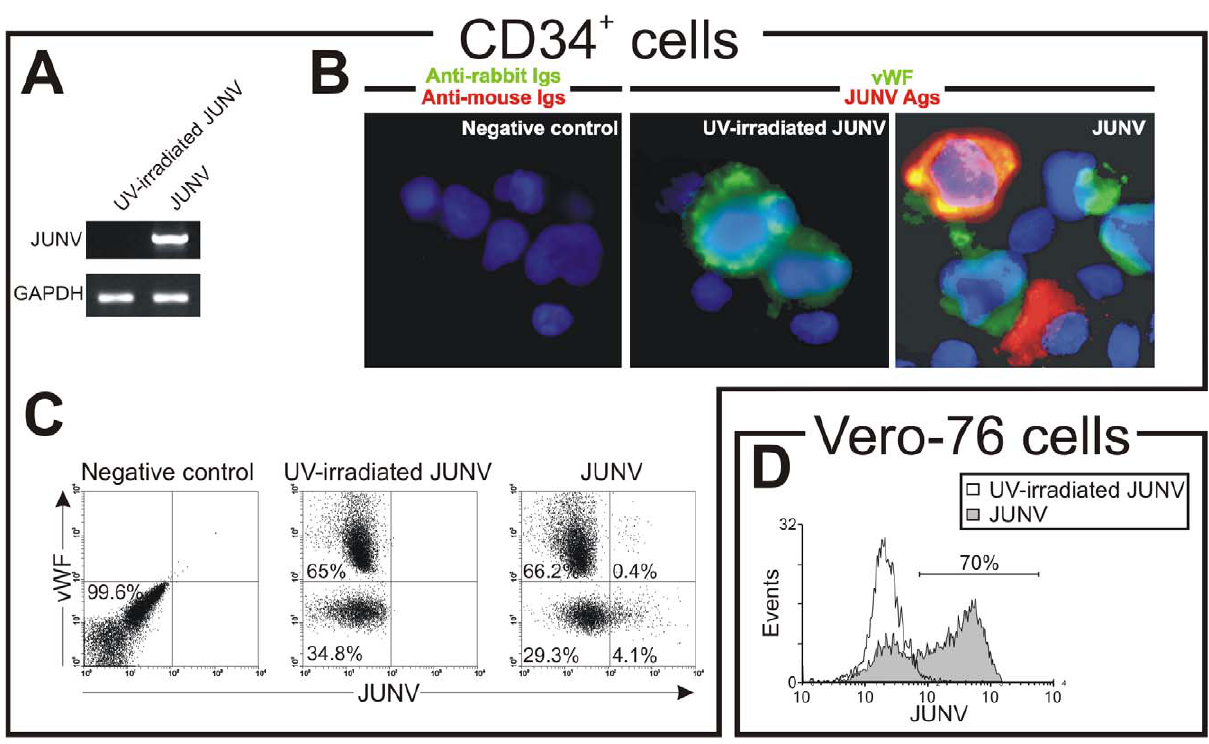
Figure 4. JUNV replication in CD34 + cells. CD34 + cells were inoculated with UV-irradiated JUNV or JUNV and stimulated with TPO for ten days. Viral replication was assayed by RT-PCR, immunofluorescence and flow cytometry. (A) RT-PCR studies. (B) To detect JUNV antigens by immunofluorescence cells were washed, cytocentrifuged on silanized glasses, fixed, permeabilized and incubated first with a pool of specific mAbs against JUNV and a rabbit-anti-human vWF polyclonal Ab to identify megakaryocytes, and then with FITC-conjugated anti-rabbit (green) and Cy3- conjugated anti-mouse Igs (red). The slides were counterstained with DAPI and photographed at 1000 6 magnification. (C) Cells were stained as in B and then analyzed by flow cytometry. (D) As a positive control, JUNV-susceptible Vero-76 cells were inoculated with JUNV and seven days later were stained with the pool of specific mAbs against JUNV followed by Cy3-anti-mouse Igs. Negative controls in B and C were performed by incubating cells only with secondary Abs. Panels show a representative experiment of three similar